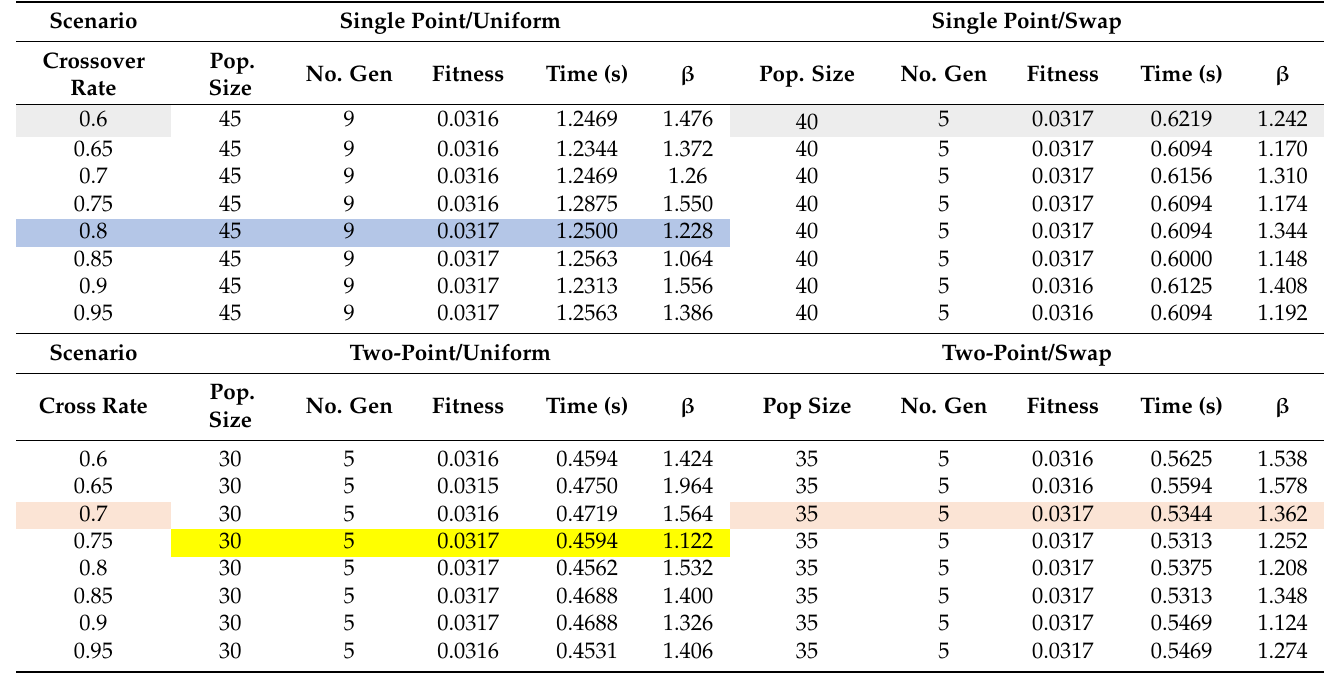
Table 2. The impact of the number of generations on the GA performance. The best results are